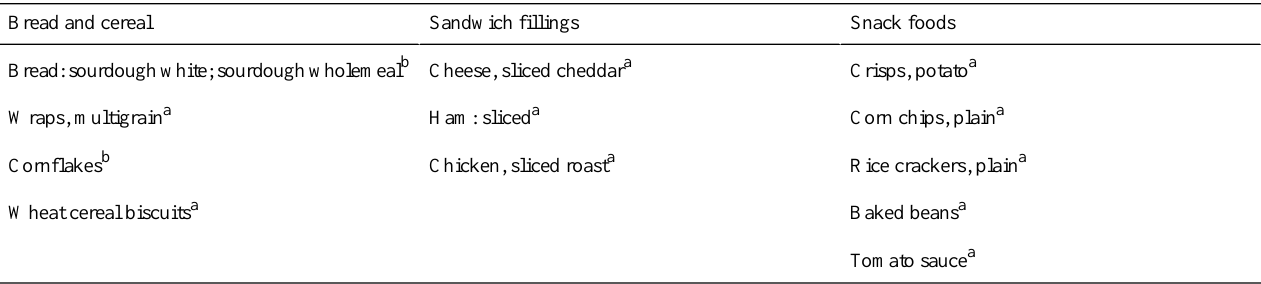
Table 2. Foods tested in sensory component.